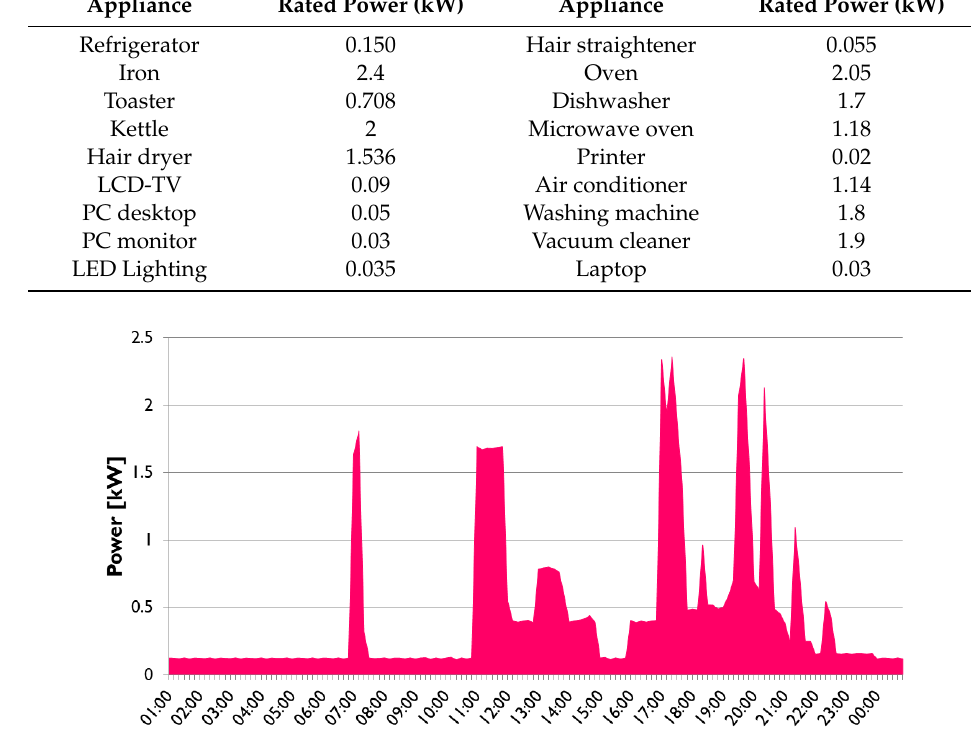
Table 1. Electrical appliances in the smart home.